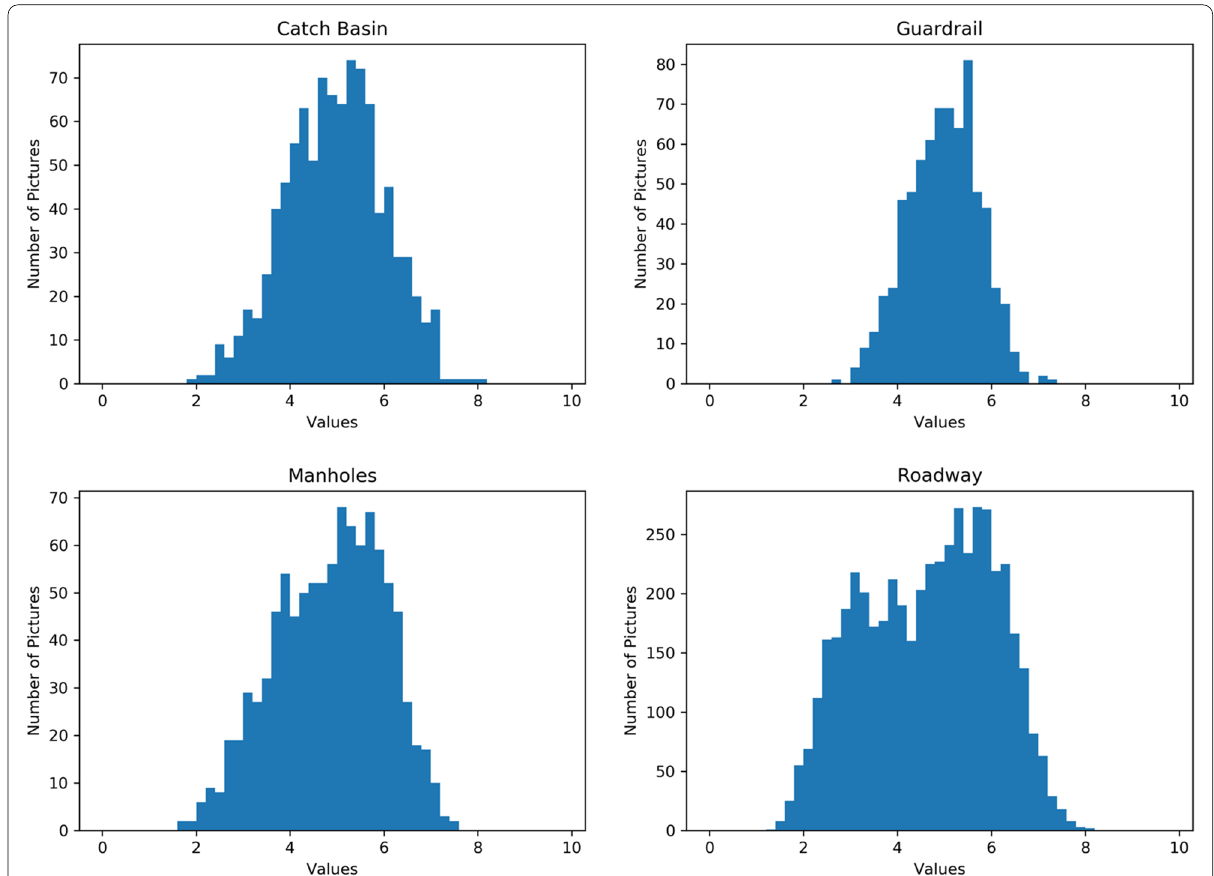
Fig. 22 Q-score of images with different facility